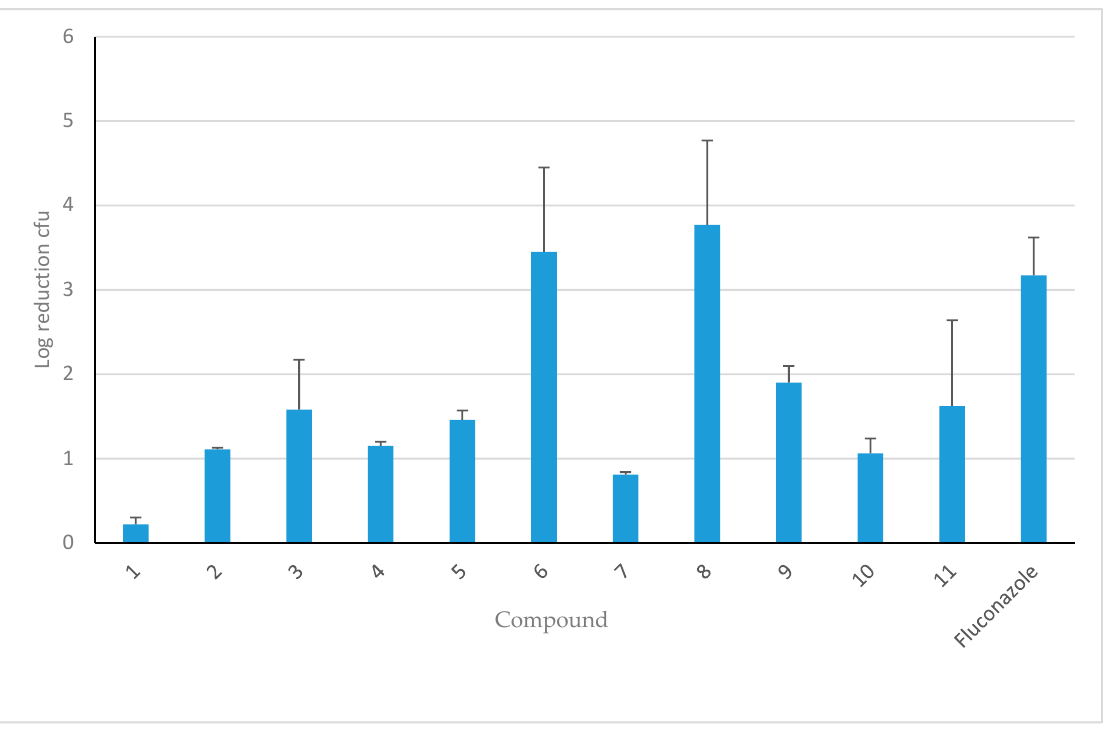
Figure 3. Comparison of HDP mimetic efficacy at 50% MTD. Mean log 10 reduction of colony forming units (cfu) of Candida albicans following SC treatment with different HDP mimetics at 50% of the maximum tolerated dose (MTD) 2 h following IV infection with 3.5 × 10 4 cfu/mouse for 24 h. For comparison, female Swiss CD.1 mice were gavaged 2 h after infection with 20 mg/kg fluconazole for 24 h, which caused a 3-log reduction in cfu. Groups were compared to a control group dosed with kleptose and infected with 3 × 10 4 cfu C. albicans per mouse.